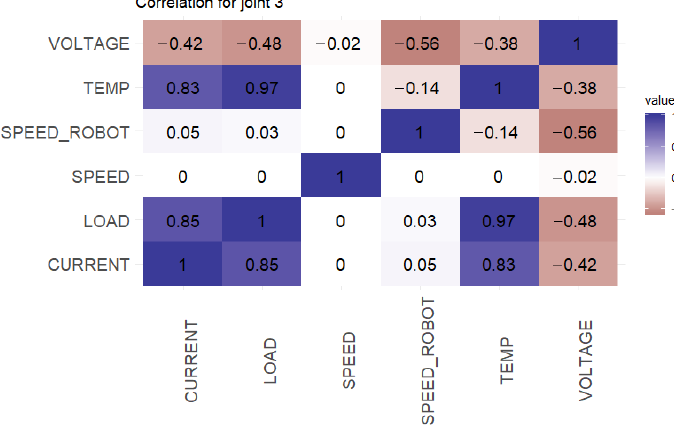
Figure 7. Correlation of joint